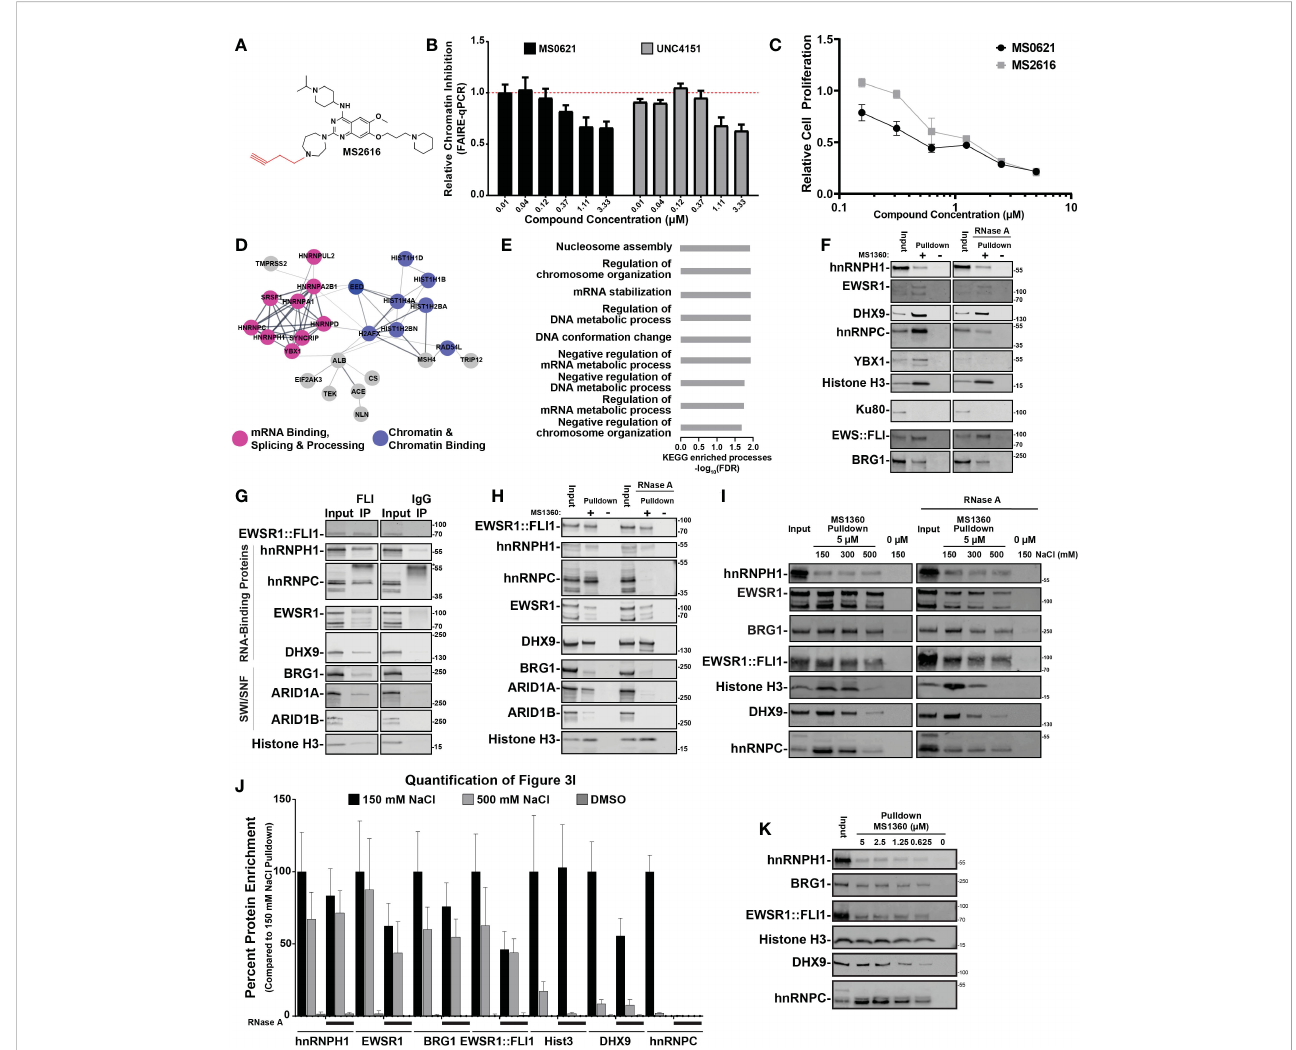
FIGURE 3 MS0621 active analog interacts with a macromolecular complex enriched with RNA-binding proteins (A) Chemical structure of MS2616, alkyne- substituted analog of MS0621. (B) FAIRE-qPCR at the screening loci in EWS894 cells treated with the indicated doses of MS0621 or UNC4151 for 16 hours. Results are shown as Relative Chromatin Inhibition. Error bars represent the standard deviation of 5 technical replicates. (C) Cell proliferation curves for EWS894 cells treated with the indicated doses of MS0621 or MS2616 (twofold dilutions from 5 m M to 0.15625 m M) or vehicle control for 3 days. Proliferation was assessed on day 3 by WST assay. Results are shown as the fold change of vehicle treated cells. Error bars represent the SD of three biological replicates. (D) STRING diagram displaying interactions networks between proteins identi fi ed by mass spectrometry in EWS894 cells. (E) KEGG Enriched Biological Processes GO terms for proteins identi fi ed by mass spectrometry in EWS894 cells. Results shown are the -log 10 FDR for the top 50% of enriched GO terms. (F) Western blot con fi rmation of proteins identi fi ed by mass spectrometry. Proteins chemiprecipitated by 5 m M